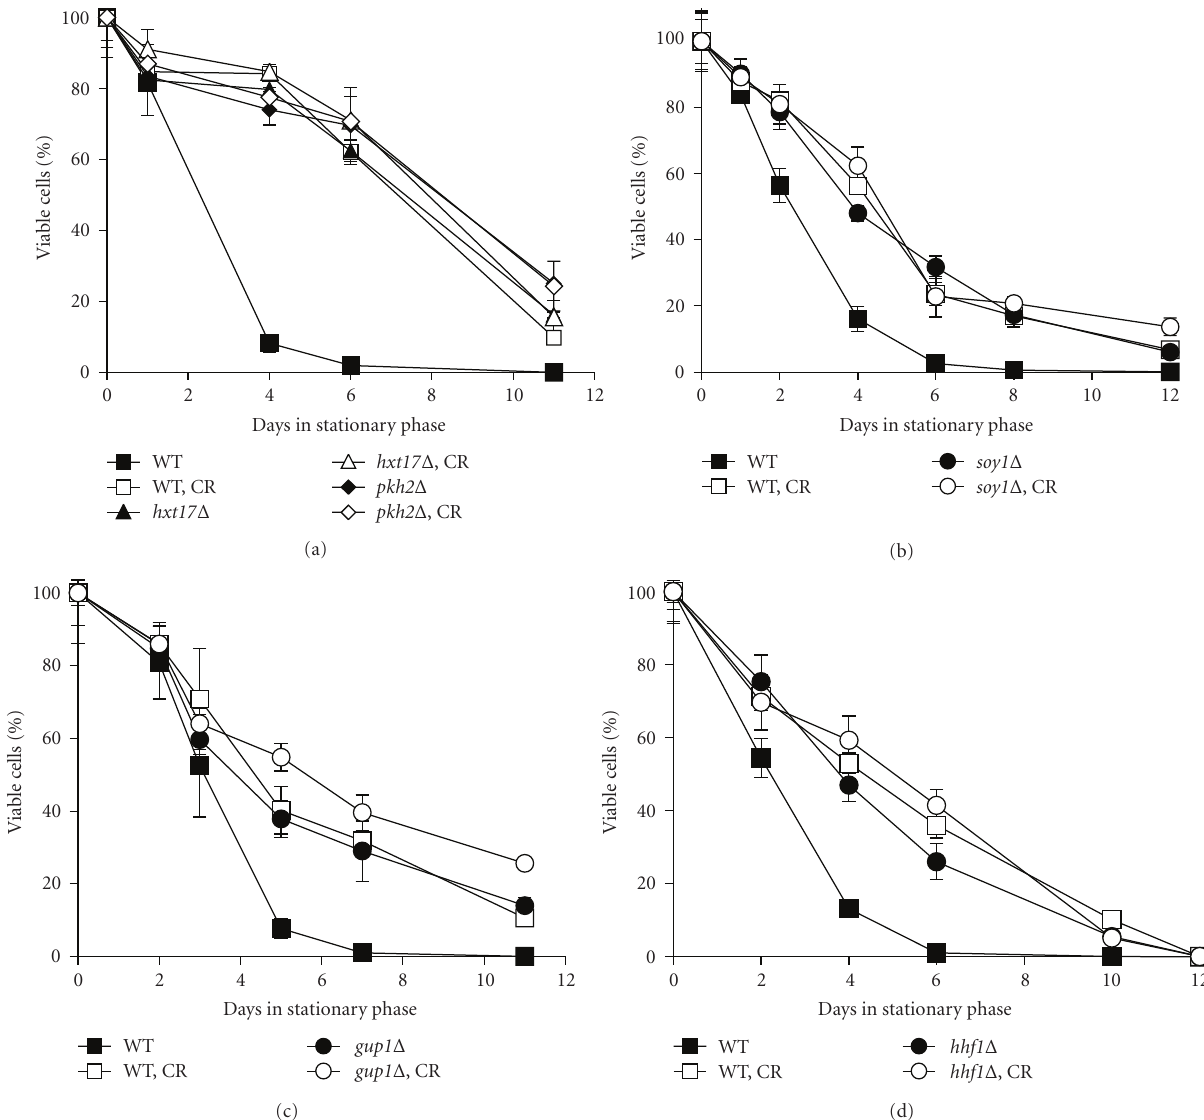
Figure 2: Chronological lifespan (CLS) analysis of potential CR genetic mimics. (a)–(d) Potential CR-mimicking high-NO mutants show extended CLS, and most do not significantly further increase the CLS of cells grown in CR. (c) Although CR further increases gup1 Δ -induced CLS ( gup1 Δ versus gup1 Δ , CR; P = . 035), gup1 Δ does not further increase CR-induced CLS (CR versus gup1 Δ , CR; P = . 073). (d) Although CR further increases hhf1 Δ -induced CLS ( hhf1 Δ versus hhf1 Δ , CR; P = . 02), hhf1 Δ does not further increase CR-induced CLS (CR versus hhf1 Δ , CR; P = . 28). One representative set of three independent experiments, each conducted in quadruplicate, is shown. Error bars denote standard deviations. WT: BY4742 wild-type control; CR: 0.5% glucose; Δ : gene deletion. Numbers on the x -axes denote the number of days after entering stationary phase (nonmitotic state). Pairwise statistical analysis of CLS is shown in Supplemental Table